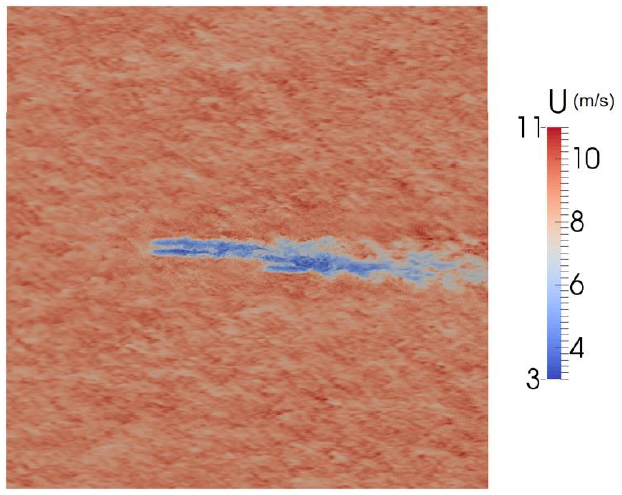
Figure 10. Instantaneous streamwise velocity (U) contour.